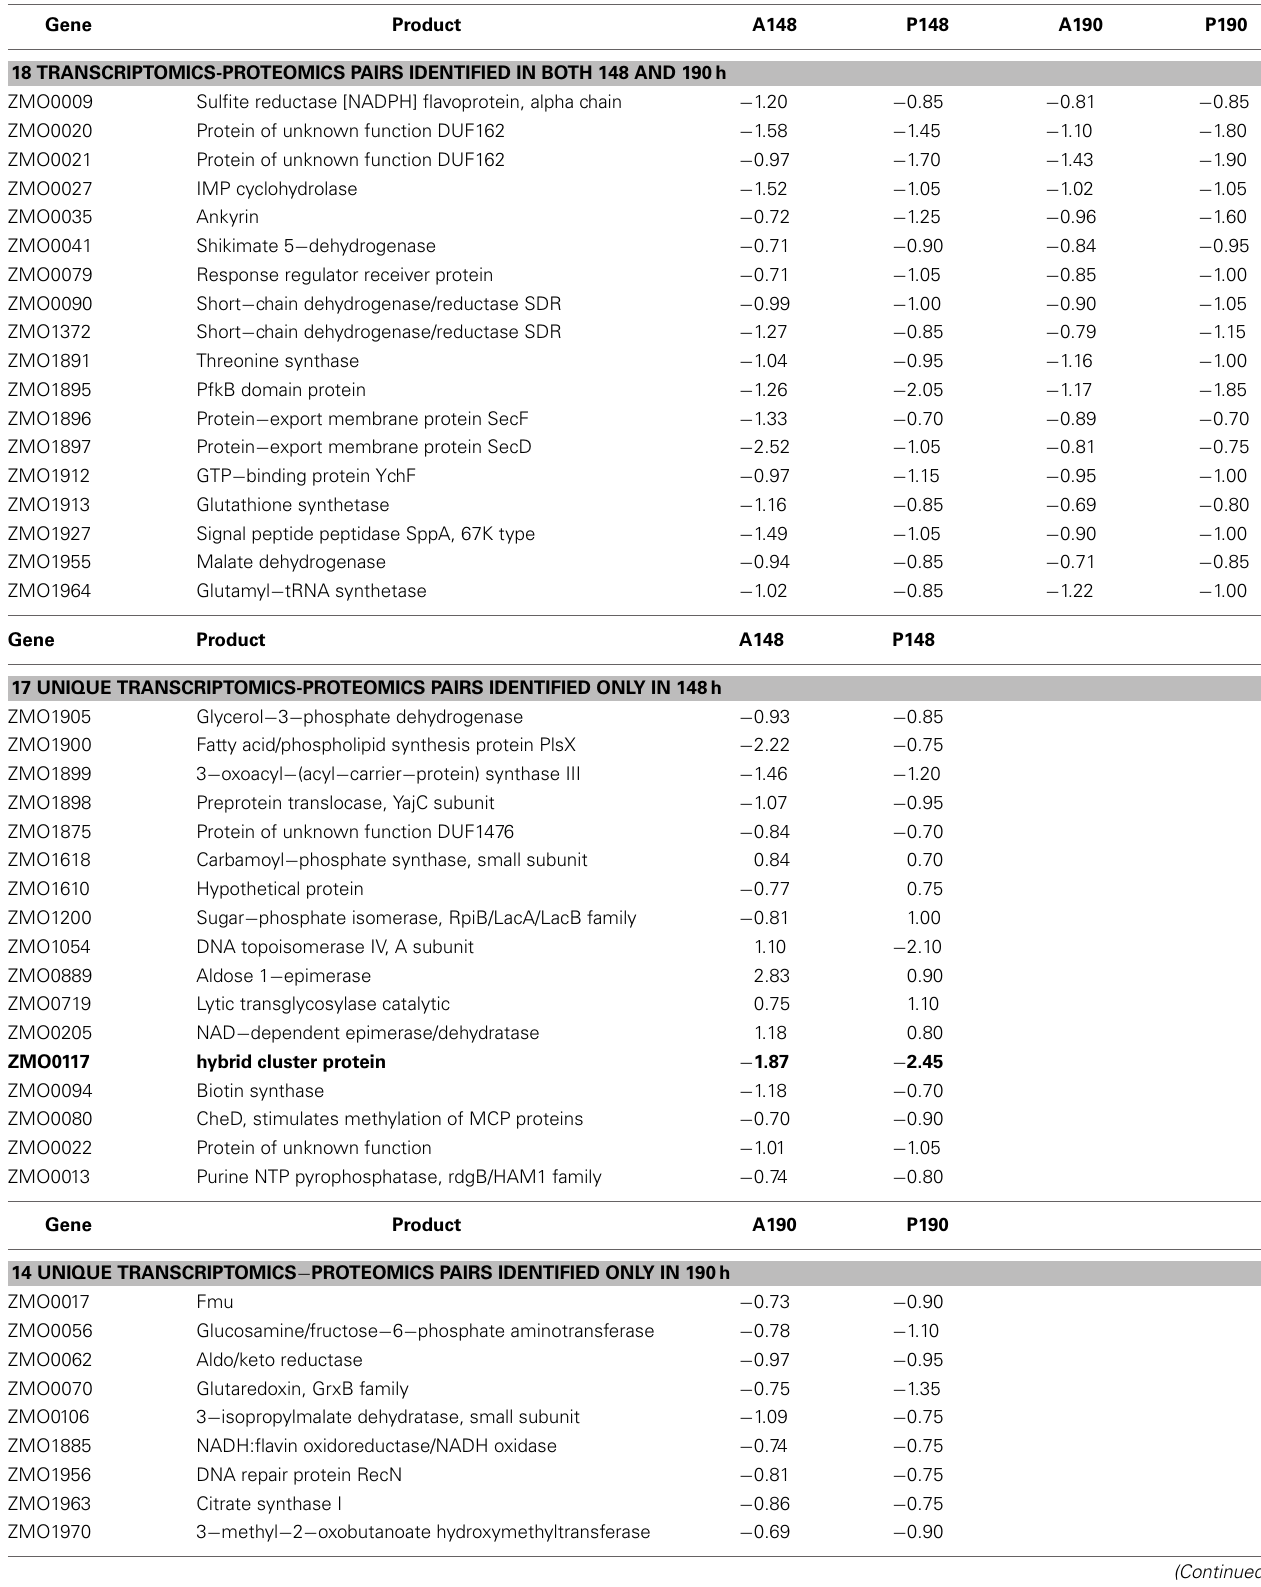
Table 1 | Gene-protein pairs identified in both transcriptomic and proteomic studies at both 148 and 190h post-inoculation, and those only identified in either 148 or 190h